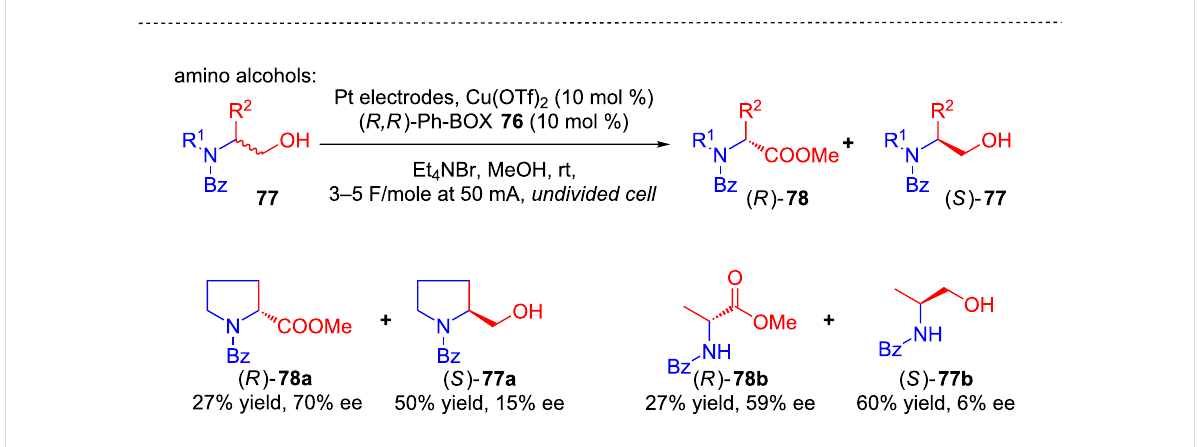
lytic chiral Co(II)-( R,R )salen complex 83 in DMF